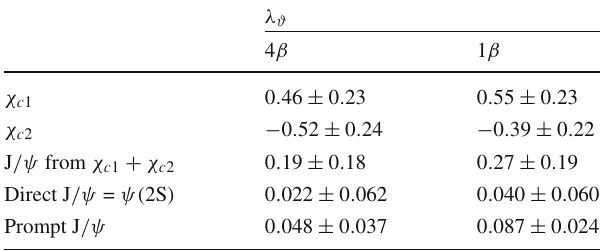
Table 4 Polarizations determined in the 4 β fit variant (for p T / M = 5) and in the 1 β option (averaged over p T / M )